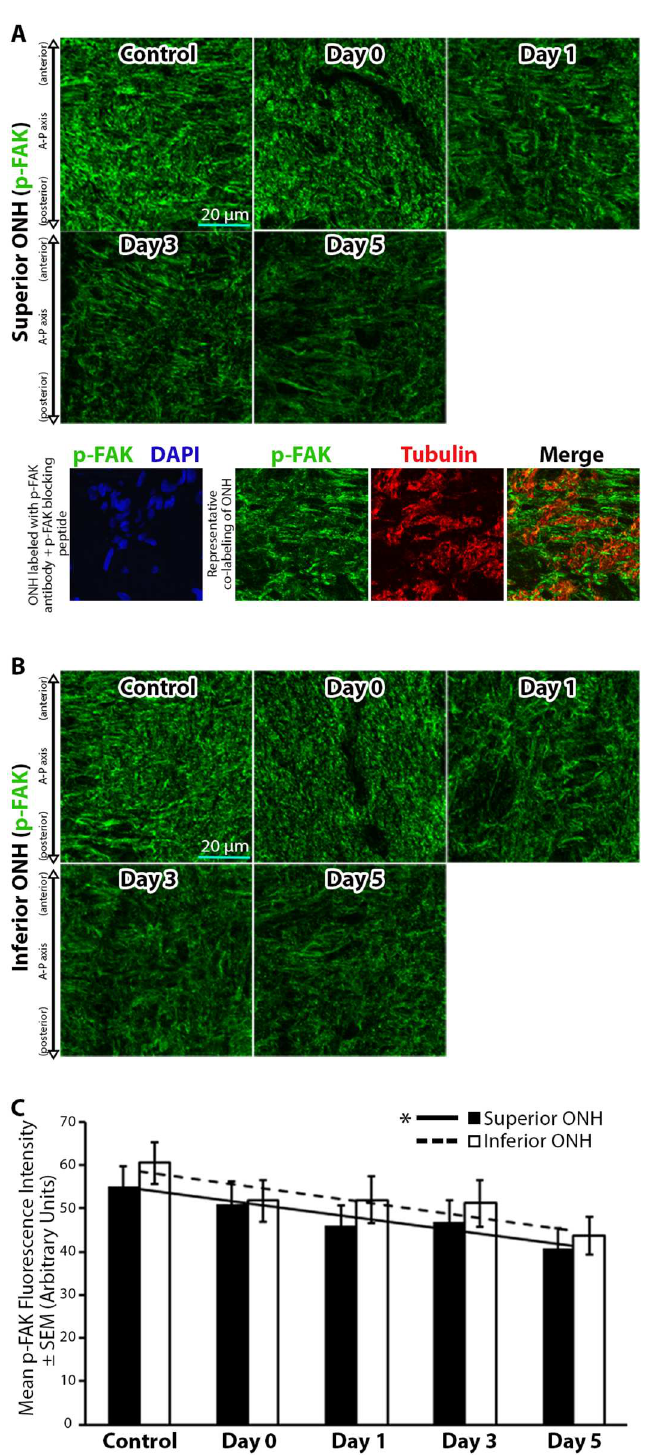
Fig 3. Focal adhesion kinase phosphorylation levels within the optic nerve head decreasesteadily after intraocular pressureelevation. (A-B) Superiorand inferior optic nerve head(ONH) sections labeled with anti-phosphorylated focal adhesion kinase (p-FAK) antibodies in control eyes and eyes exposedto 8 hours of intraocularpressure (IOP) elevation.The bottom panels in (A) includea validation of antibody specificity using a p-FAK specific blockingpeptide(bottom left panel), as well as an exampleof